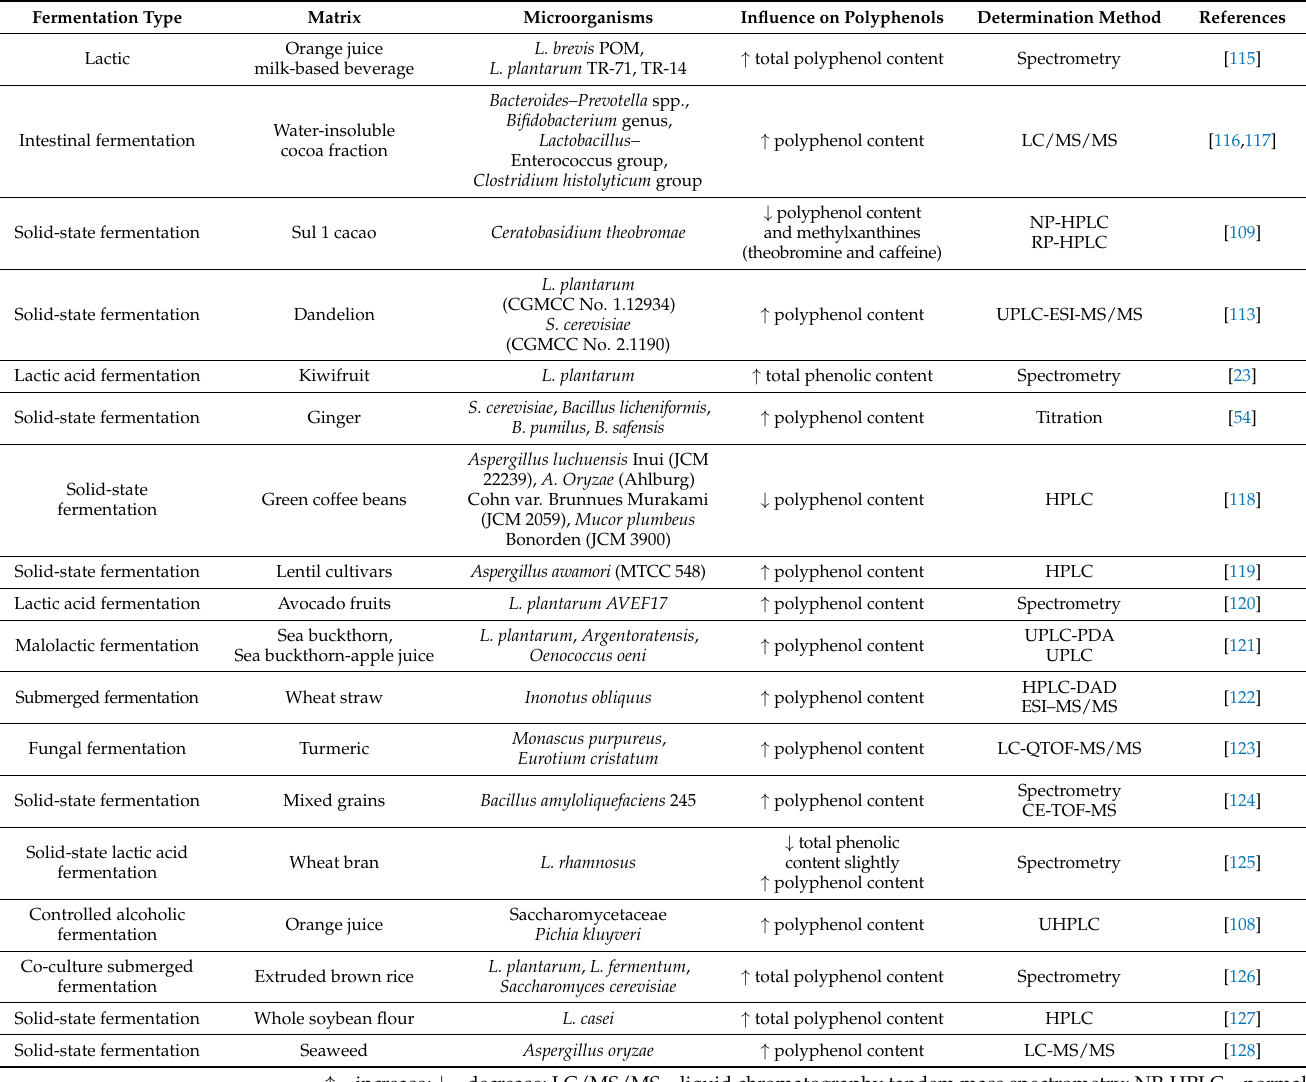
Table 3. Impact of different fermentation processes on bioavailability of